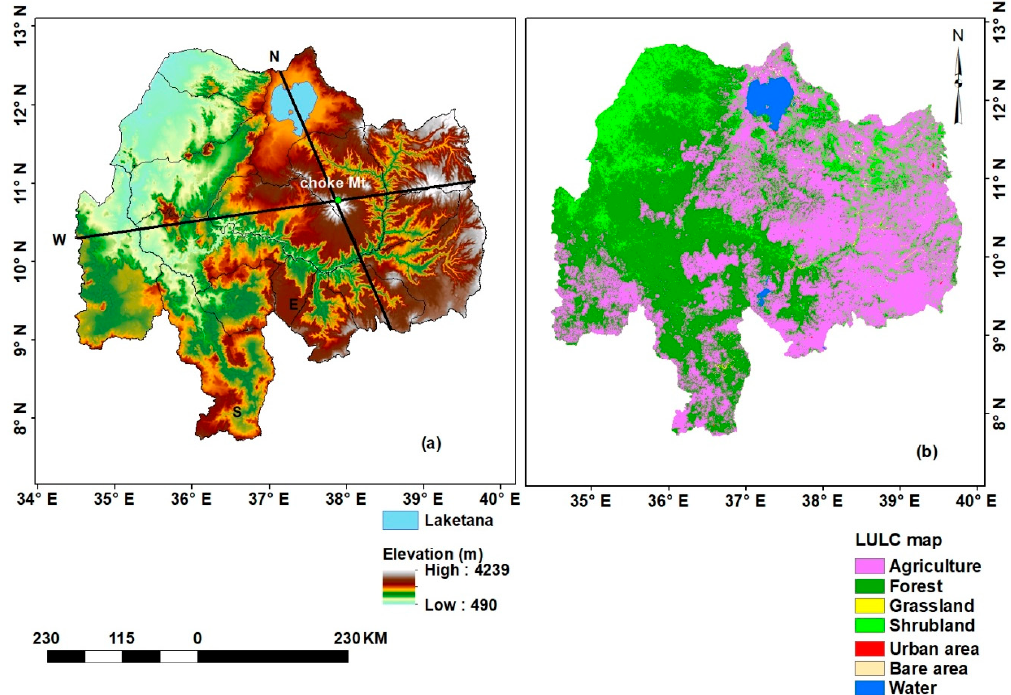
Figure 2. ( a ) Digital elevation model (DEM) with sub-basins of the Upper Blue Nile Basin (two transects from north to south-east (NS) and from west to east (WE)), and the green point shows the location of the peak “Choke” Mountain; ( b ) The land use land cover map of the UBNB for 2015 extracted from the European Space Agency’s Climate Change Initiative (ESA CCI) land cover map.